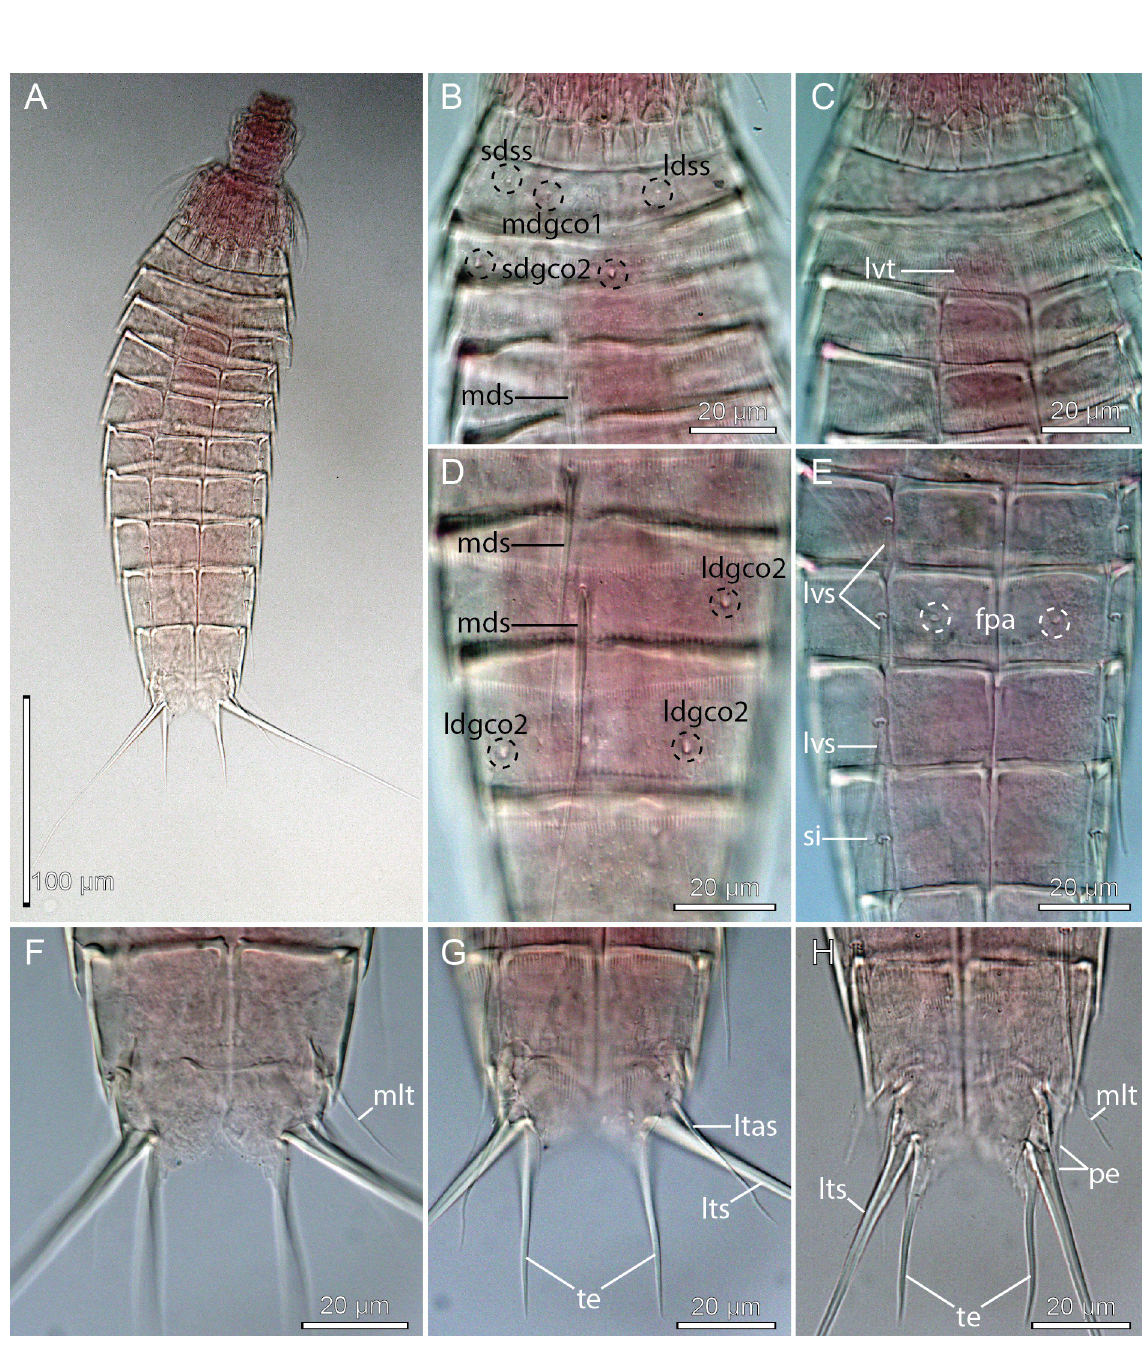
Fig. 22. Light micrographs showing overviews and details of Echinoderes yamasakii sp. nov., holotype, ♀ (A–G) (NHMD-226471) and paratype, ♂ (H) (NHMD-226479). A . Ventral overview. B . Segments 1 to 4, dorsal view. C . Segments 1 to 4, ventral view. D . Segments 7 to 10, dorsal view. E . Segments 6 to 9, ventral view. F . Segments 10 to 11, focused on midlateral tube. G . ♀, segments 10 to 11, ventral view. H . ♂, segments 10 to 11, ventral view. Abbreviations: fpa = female papillae; ldgco2 = laterodorsal glandular cell outlet type 2; ldss = laterodorsal sensory spot; ltas = lateral terminal accessory spine; lts = lateral terminal spine; lvs = lateroventral spine; lvt = lateroventral tube; mdgco1 = middorsal glandular cell outlet type 1; mds = middorsal spine; mlt = midlateral tube; pe = penile spine; sdgco2 = subdorsal glandular cell outlet type 2; sdss = subdorsal sensory spot; si = sieve plate; te =